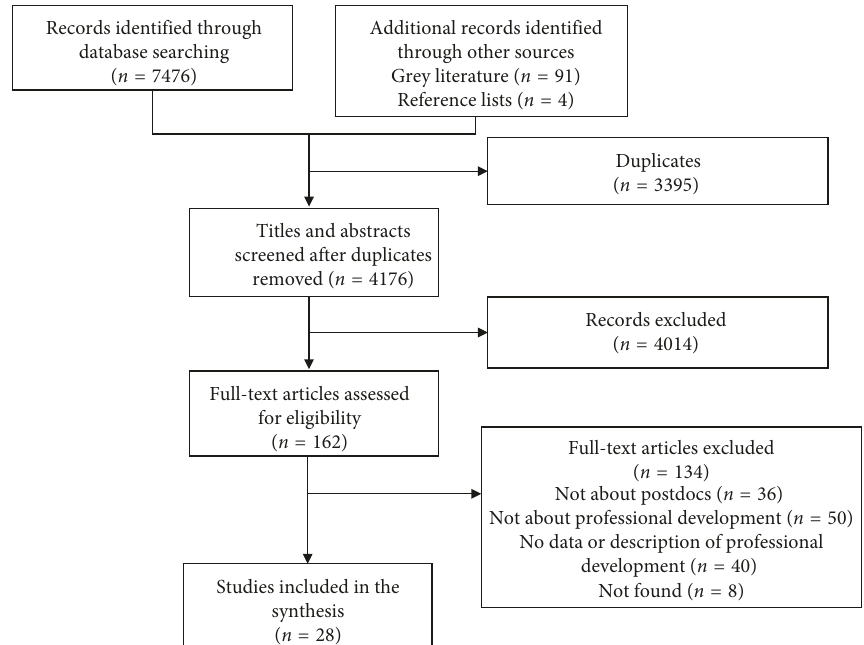
Figure 1: Flow of literature through the review. Table 2: Characteristics of included